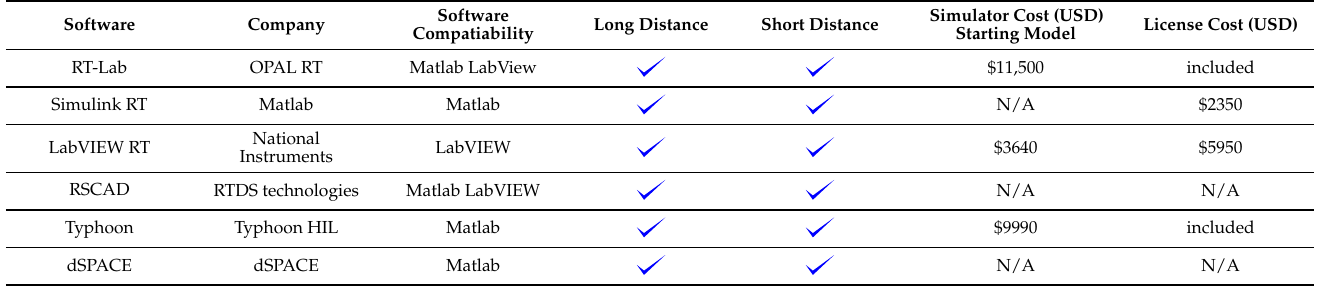
Table 4. RT Hardware and